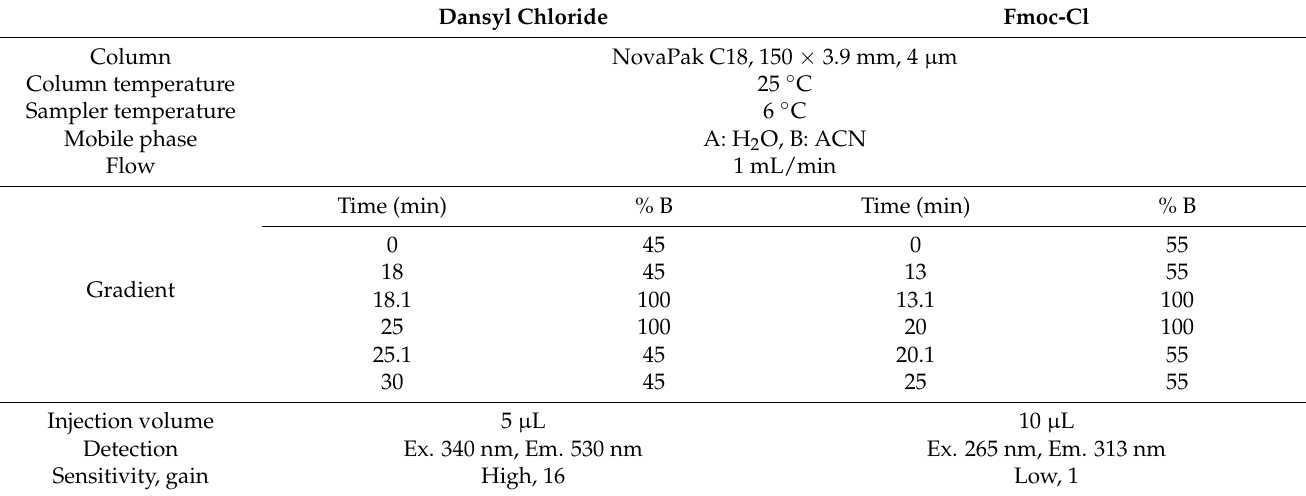
Table 1. Comparison of the chromatographic conditions of analysis of both the dansyl chloride and Fmoc derivatives. Dansyl Chloride Fmoc-Cl Column Column